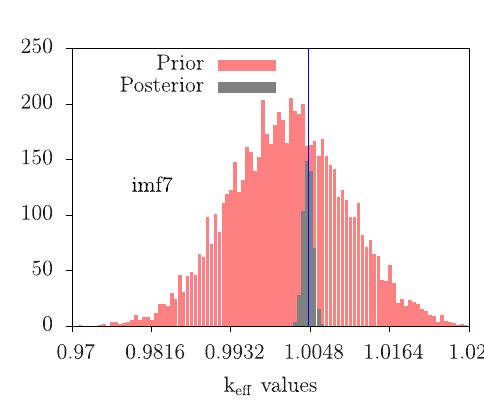
Fig. 12. Prior and posterior distributions of k eff for imf7 benchmark. The blue line indicates the experimental value.